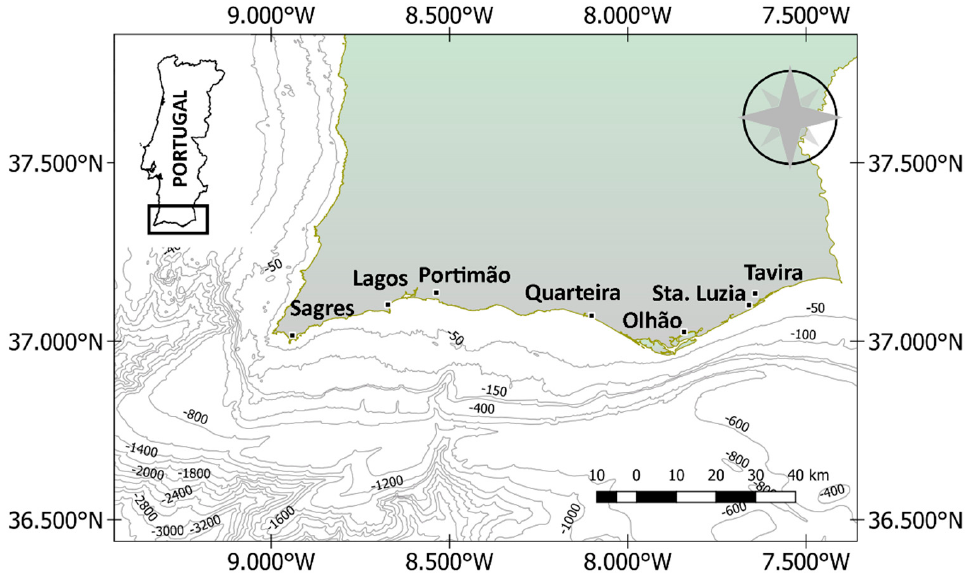
Figure 1. Map of the Algarve with all the ports where questionnaires were conducted.